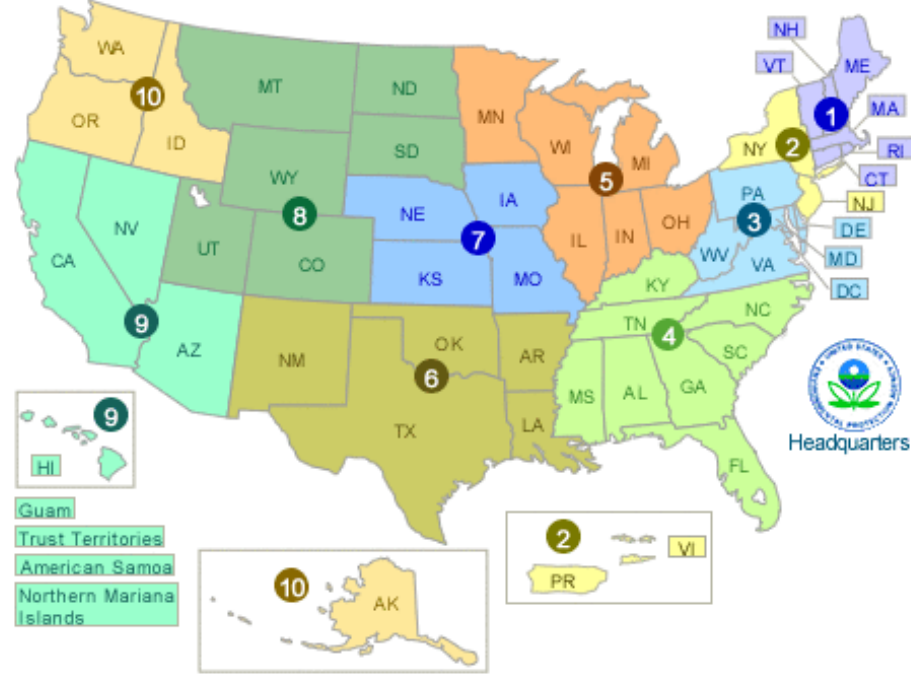
Figure 1. U.S. Environmental Protection Agency (EPA) region distribution. The numbers demonstrate ten regions within the U.S. A total of 105 respondents participated from each of the 10 regions (n = 937 valid responses).